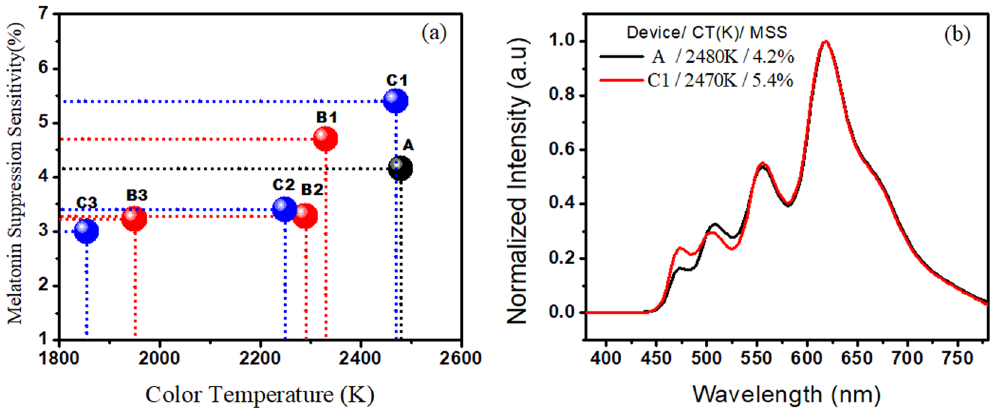
Figure 3. ( a ) Effect of color temperature of the studied wet-processed OLEDs on the melatonin suppression sensitivity (%) and ( b ) comparison of electroluminescence spectra of Device A and Device